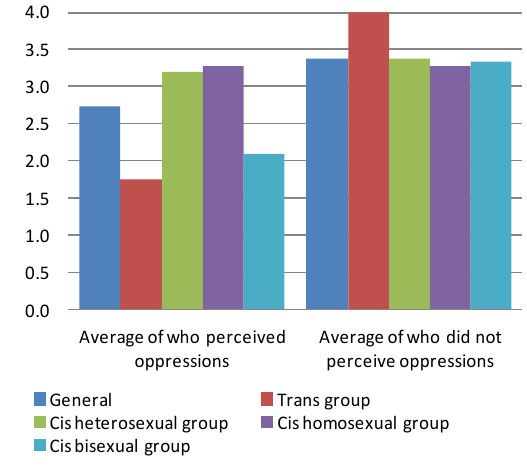
Fig. 3 – Average of grades given by each group